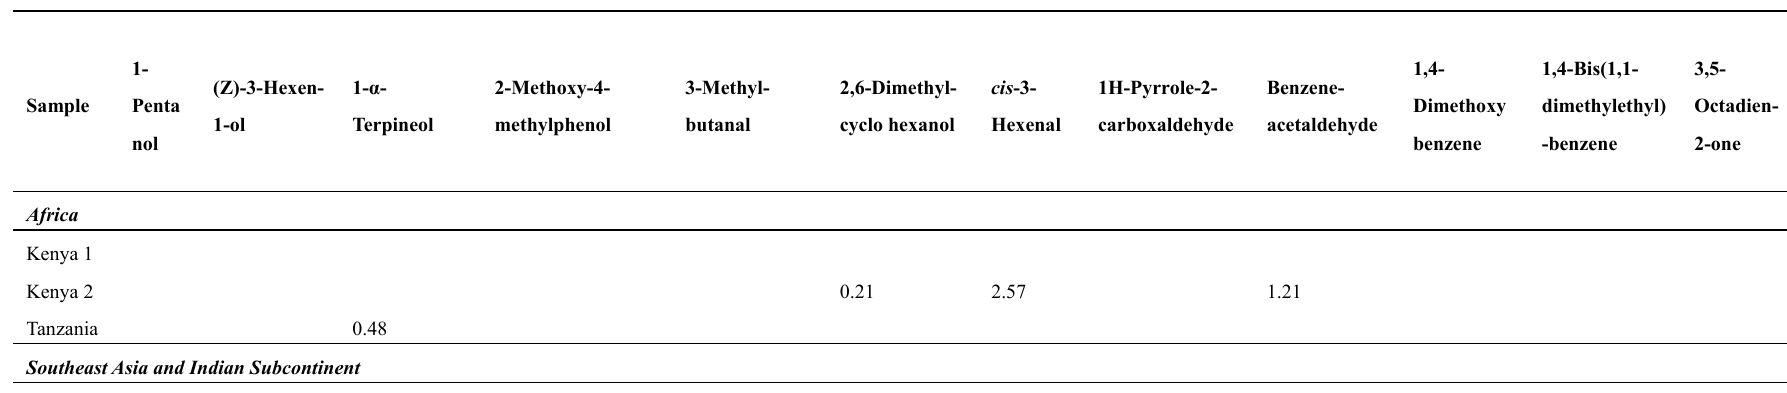
Table 3. Average concentration of 24 uncommon volatile compounds identified in the brewed green tea samples (ng/kg) a,b